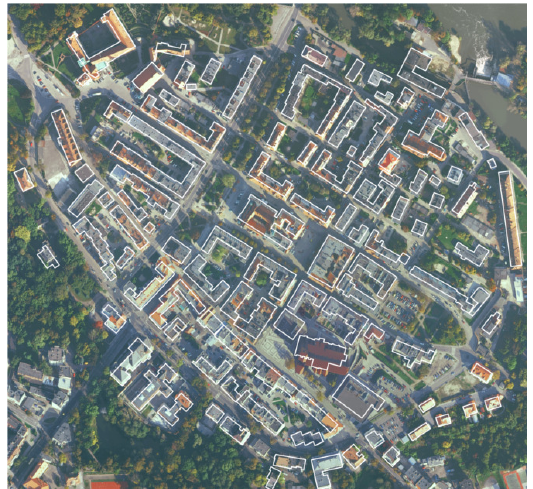
Figure 4e. Reconstructed outlines after